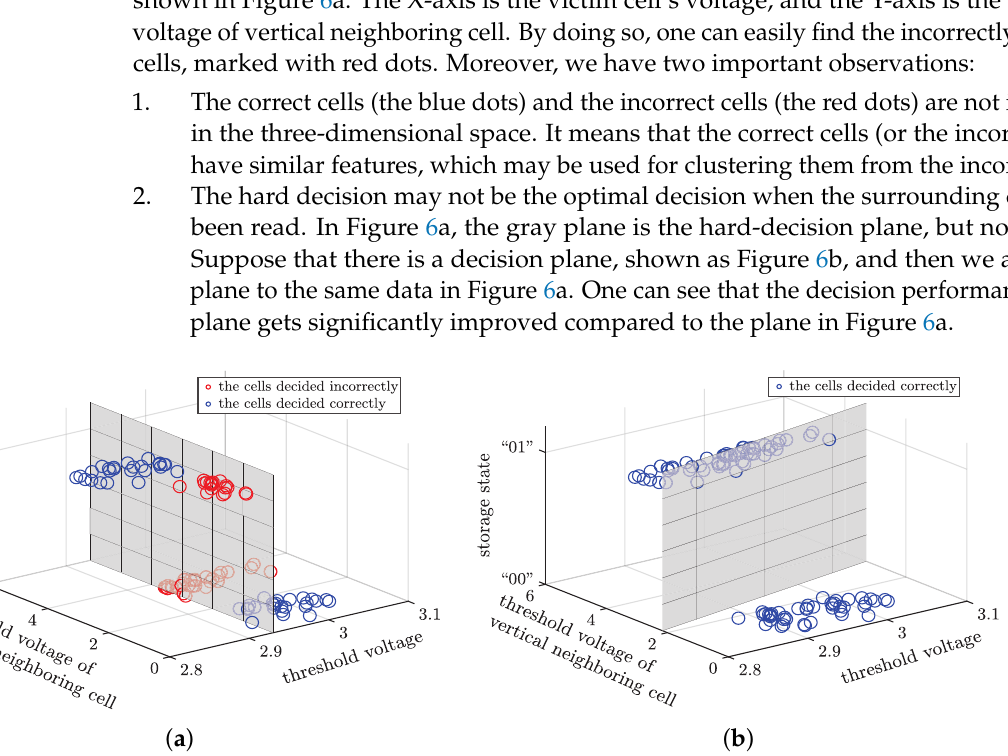
Figure 6. Illustration of the decision of least significant bit (LSB) in the NAND flash memory. ( a ) The conventional hard-decision plane in the three-dimensional coordinates. ( b ) The optimal